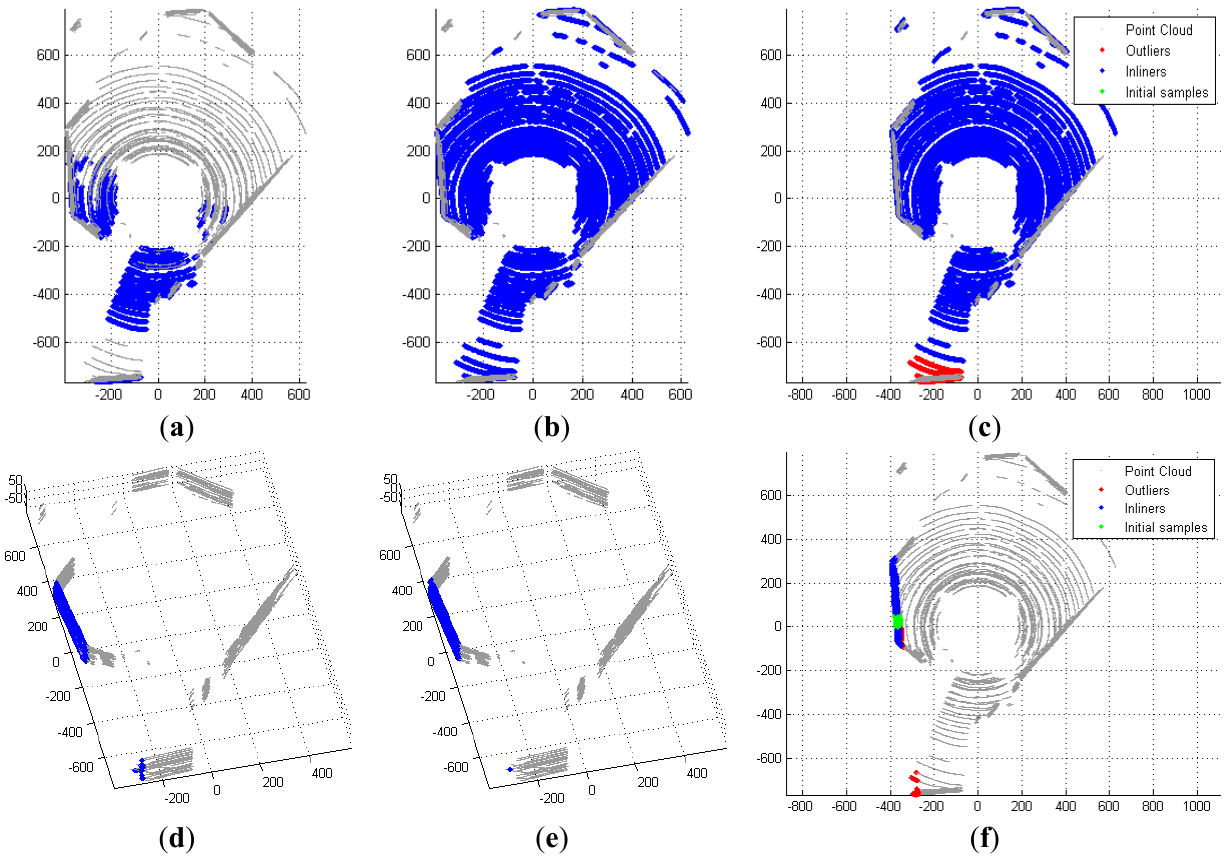
Algorithm 1. Algorithm of RANSAC-based plane